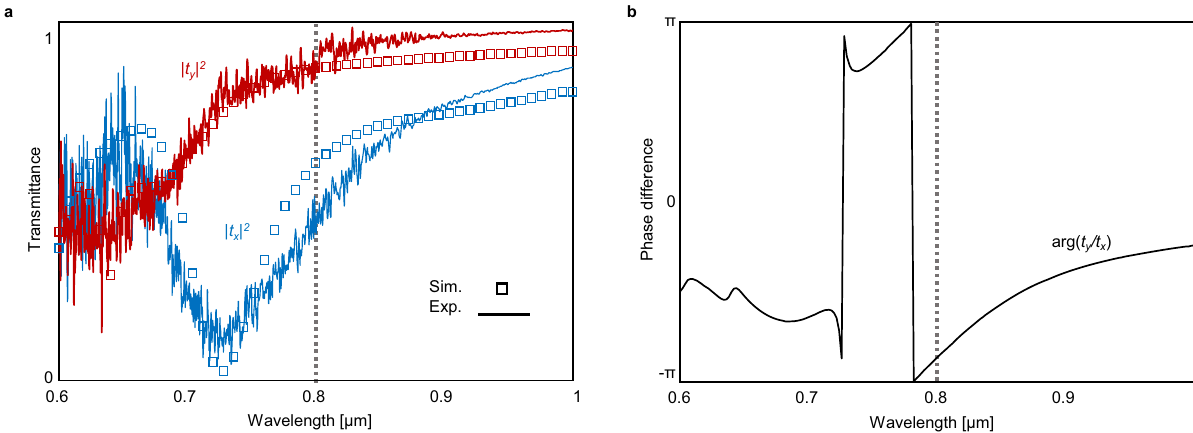
Fig. 3 Transmittance of the dielectric metasurface under normal incidence. a Simulated (markers) and measured (solid lines) transmittance under normal incidence. b Phase difference ϕ between the two polarizations obtained by numerical